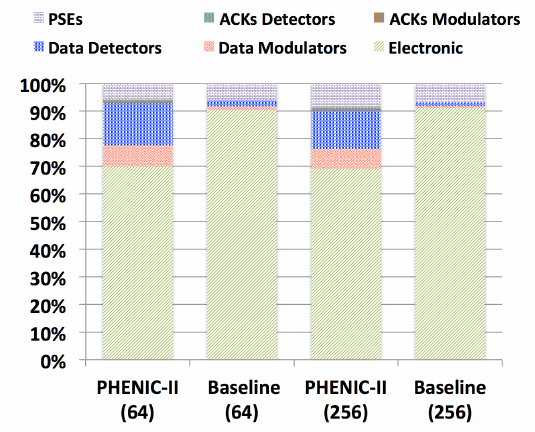
Figure 10. Total energy breakdown comparison under random traffic near the saturation.